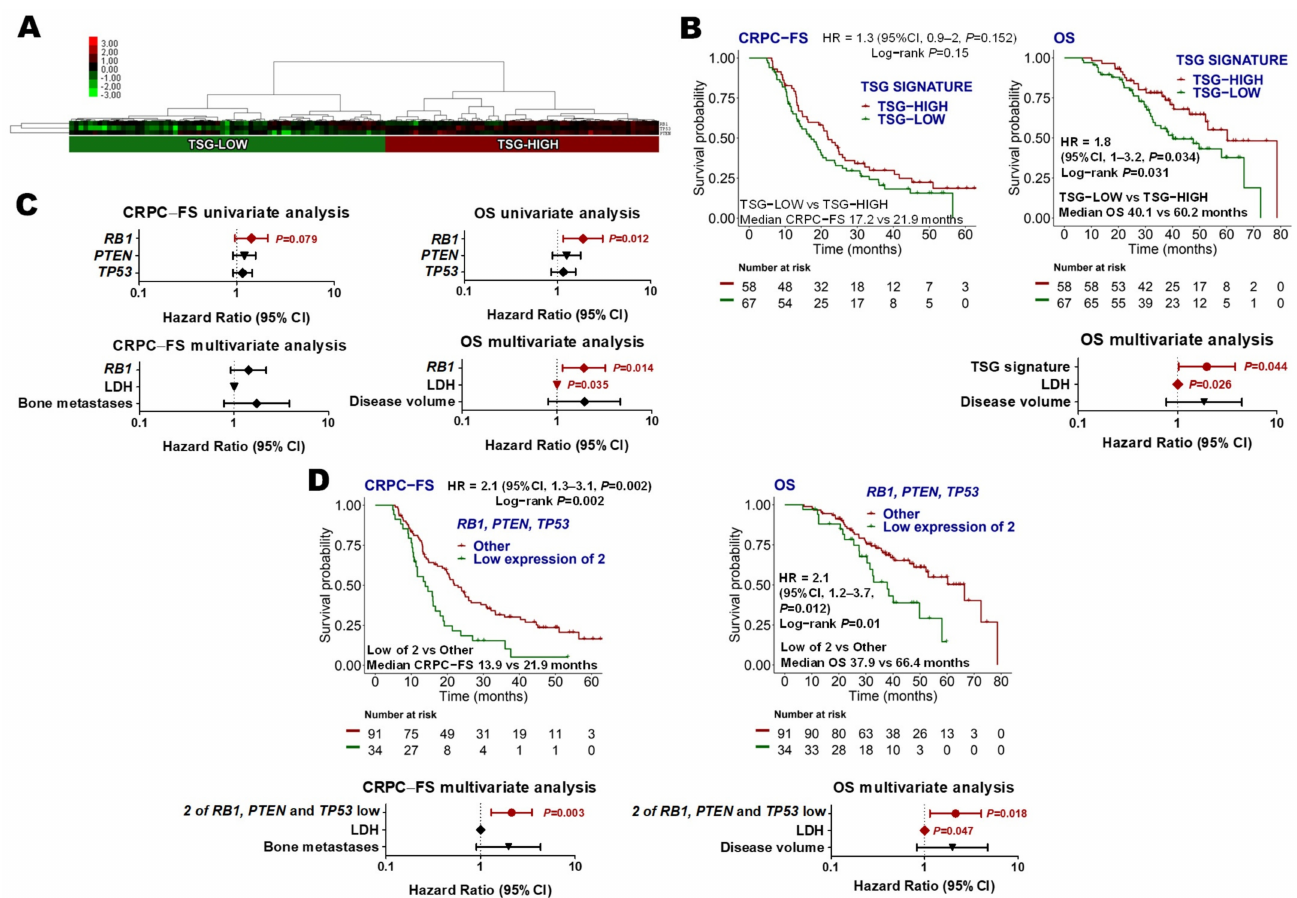
Figure 5. Tumor suppressor genes (TSG) signature. ( A ) Hierarchical clustering expression heatmap for expression values of the TSG signature; ( B ) Kaplan–Meier curves representing CRPC-free survival (CRPC-FS) and overall survival (OS) according to TSG signature and forest plot representing the multivariate analysis for OS; ( C ) forest plots representing the univariate and multivariate analysis of the individual genes of the TSG signature as continuous variables for CRPC-FS and OS. The reciprocal of the hazard ratio (HR) and the associated confidence interval (CI) were calculated; ( D ) Kaplan–Meier curves representing CRPC-FS and OS according to low expression of two out of the three TSG, and forest plots representing the multivariate analysis. Expression levels were segregated into tertiles to establish the cut-offs. LDH: lactate